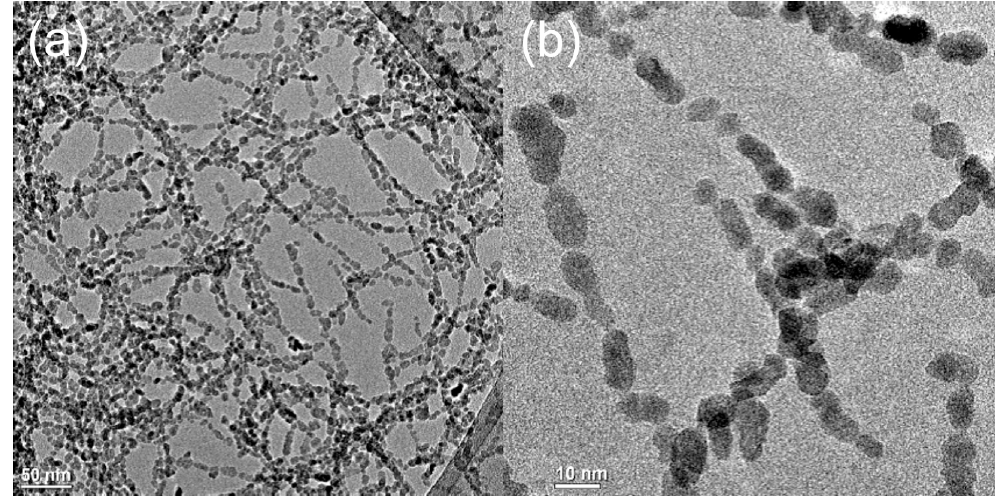
Figure 3. TEM images of the α -Fe 2 O 3 nanoparticle sample with 2.5 mM NaCl; ( b ) is enlarged view of part of ( a ).